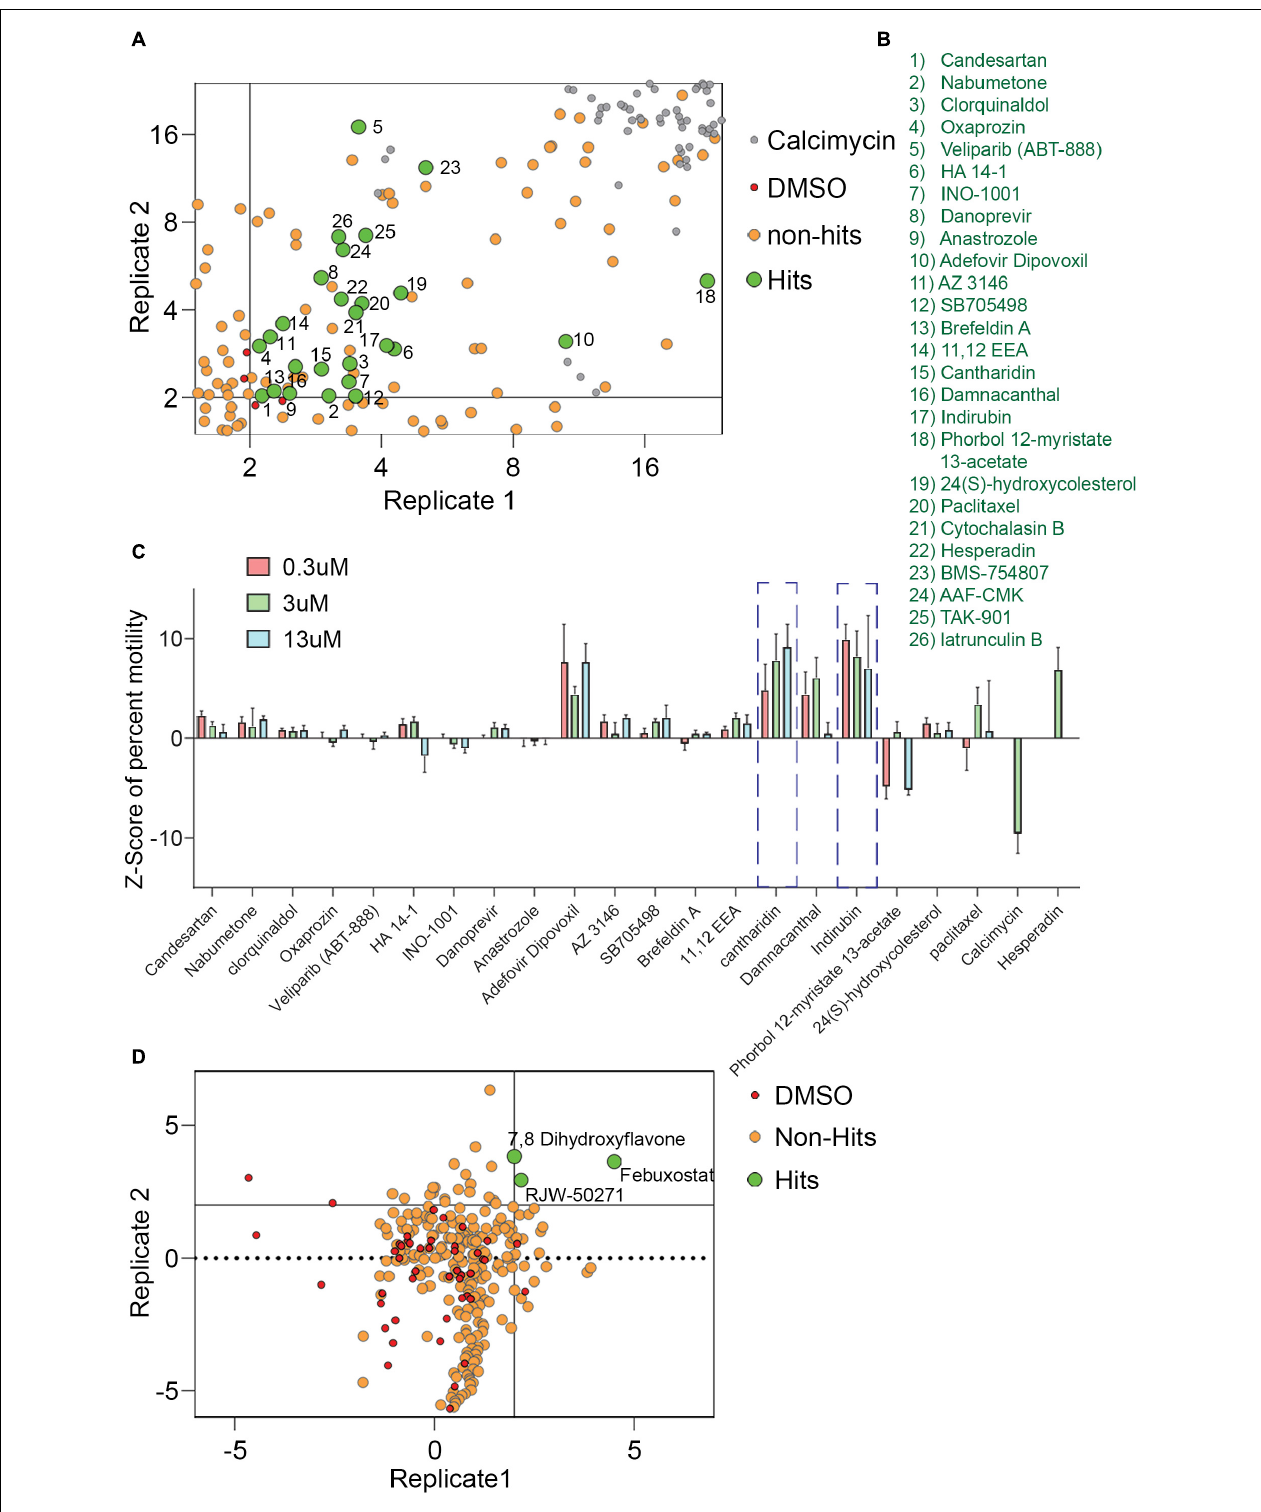
FIGURE 1 | Screen of 1,641 compounds chosen from Selleck and Biomol libraries and 240 compounds chosen from the Mechanism of Action library. (A,B) From a previously published plot of Z -scores (KS of integrated distance) of 1,641 compounds, a selected region is shown that includes compounds of interest with Z -scores > 2. Each dot represents the Z -score of an individual compound from two replicate experiments. For the present study, a Z -score of 2 ( p = 0.035) in both